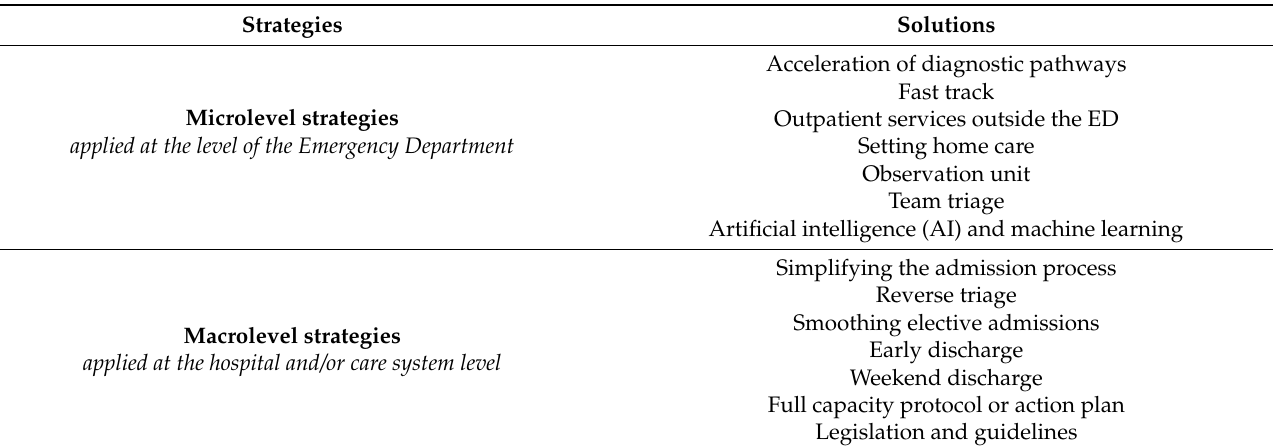
Table 3. Microlevel and macrolevel